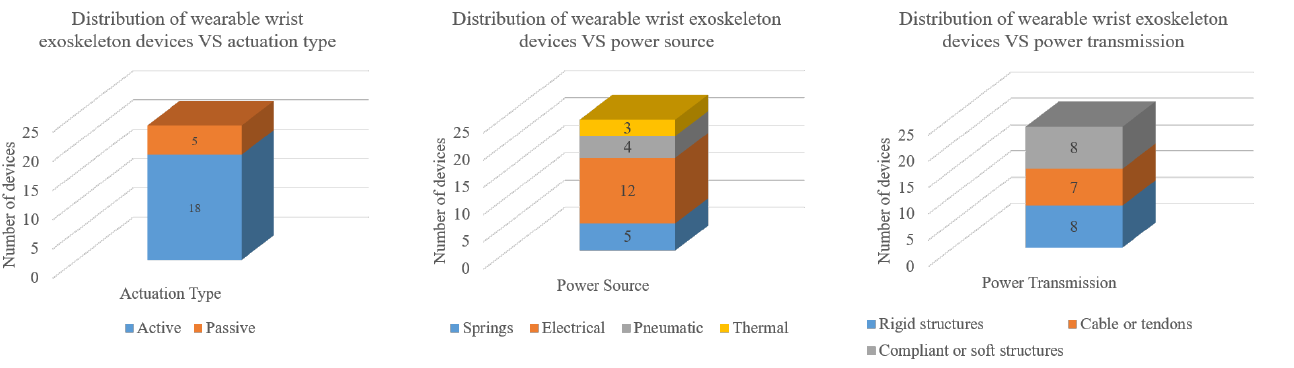
Figure 25. Wearable and portable wrist exoskeletons classified by actuation type, power source, and power transmission. A total of 22 devices have been analysed.